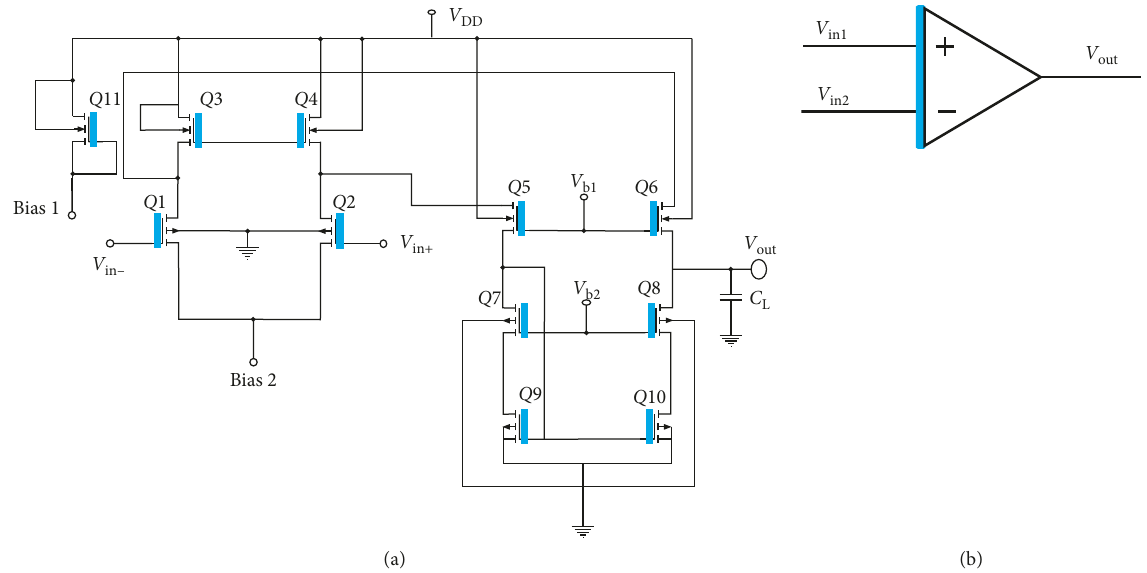
Figure 3: Proposed folded cascode operational amplifier using CNFET. (a) Schematic and (b) symbol. Table 1: Number of tubes for pitch � 8 nm.